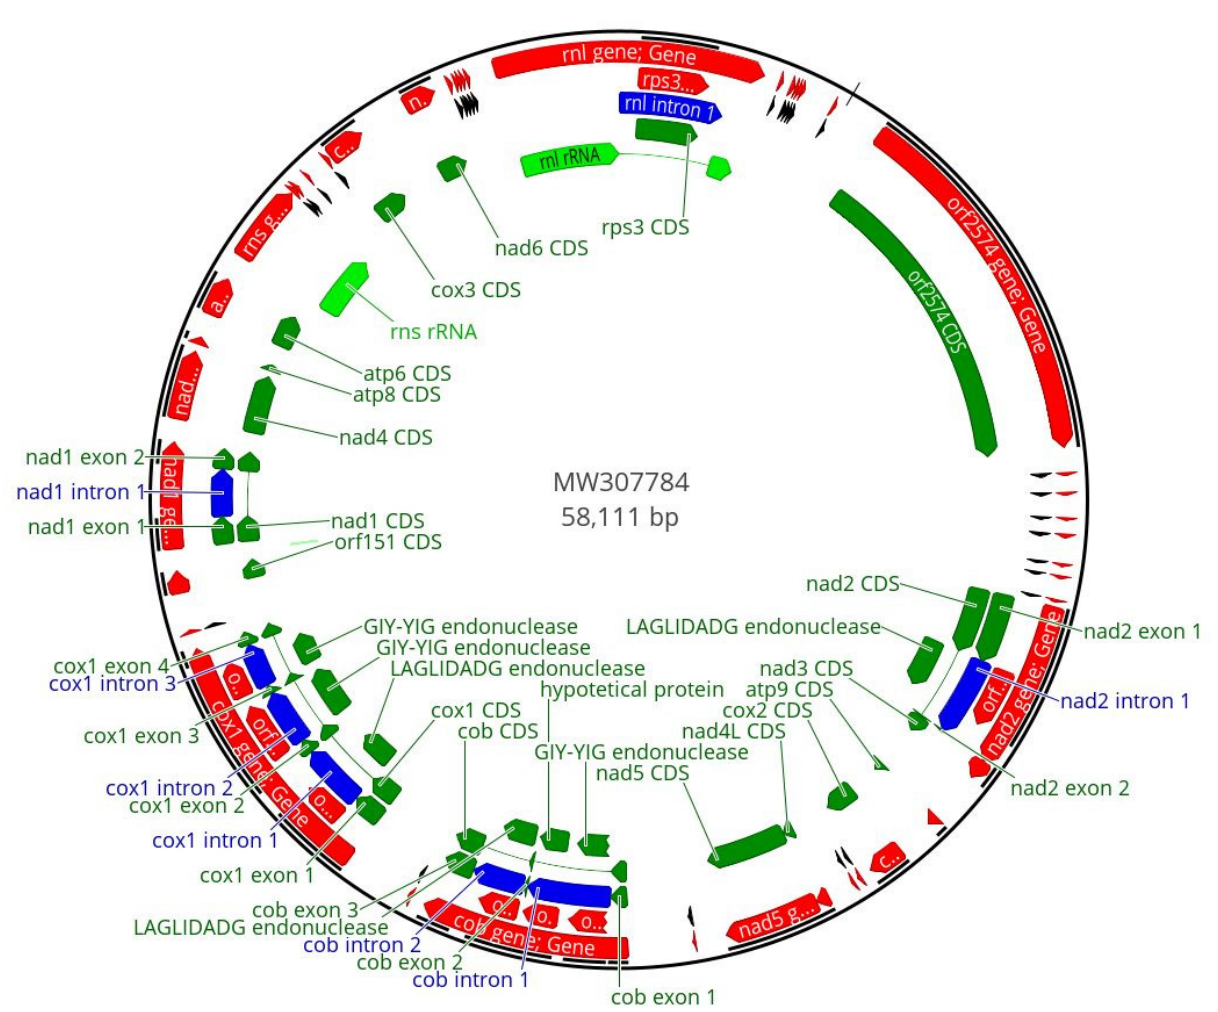
Figure 1. Graphical representation of circular mtDNA of Fusarium musae IUM_11-0508. The red colour indicates genes, the green colour refers to the coding sequences, light green refers to ribosomal subunits and the blue colour represents the introns. tRNA are represented in black.The analysis of codon usage in coding sequences did not reveal any significant difference among the whole set of analysed strains (not shown). Indeed, all the F. musae strains showed a high similarity for protein-coding regions. Two differences were present in strain F31: a triplet change for coding the same amino acid (Leu) and a single SNP, which causes a transversion. Strains FM_IHEM20180, FM_NRRL28993 and NRRL28997 showed one SNP with no effect on the amino acid sequence. All changes were localized in the nad5